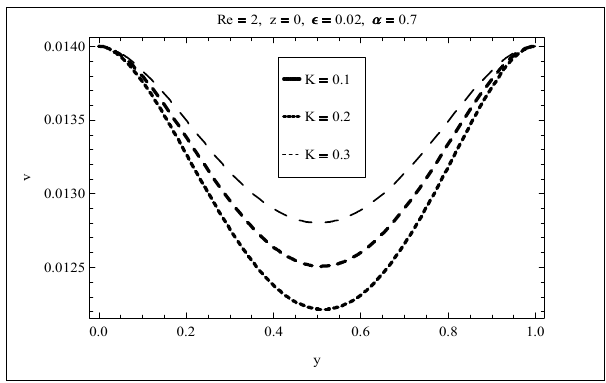
Figure 6. Effect of K on cross-flow velocity v along y .